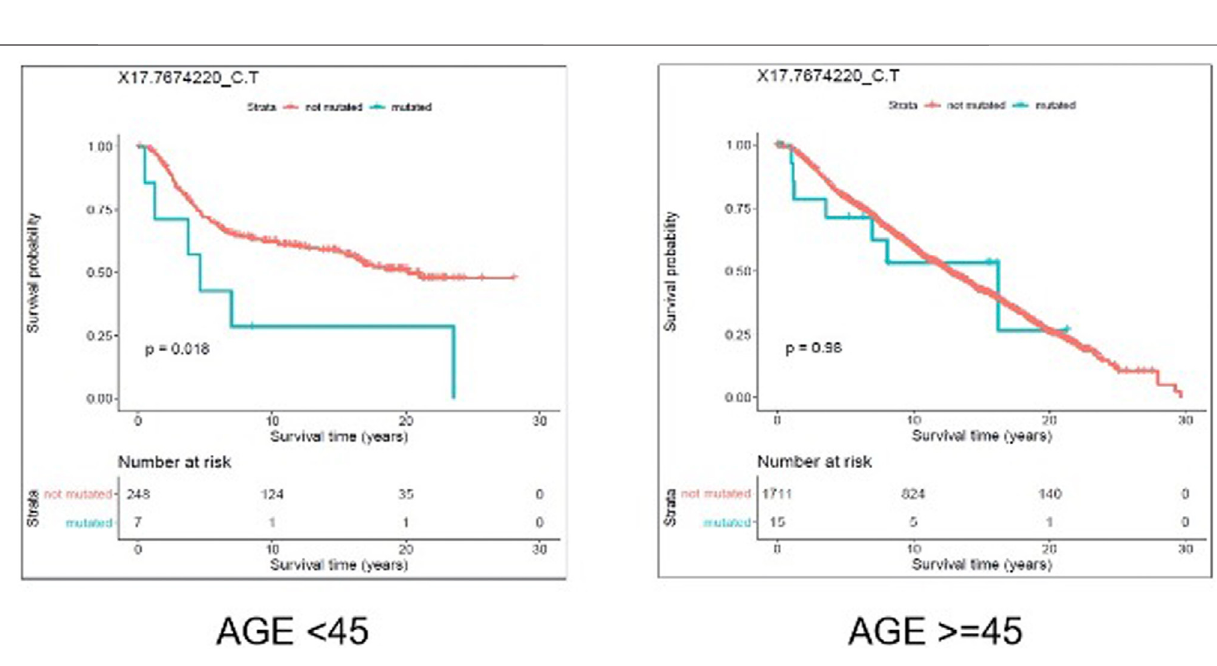
FIGURE 5 | Results from overall survival (OS) analysis comparing the survival time of breast cancer patients with and without the mutation X17.7674220_C.T. The difference between the two groups of patients (with and without the mutation) is signi fi cant among young (under 45 years of age) individuals ( p -value (cid:1) 0.018), but not signi fi cant in older patients ( p -value (cid:1)